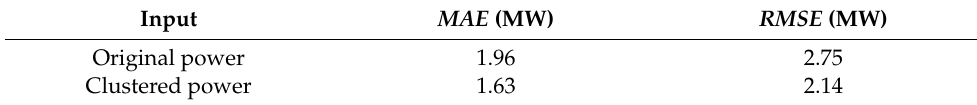
Table 2. Comparison of errors in the power calculation results of the collector system.